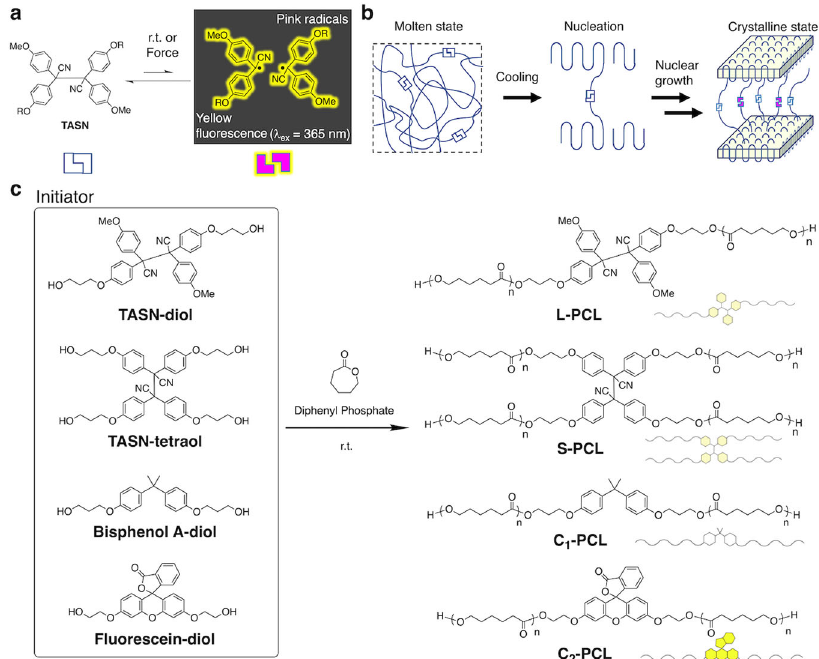
Fig. 1 Conceptual illustration of the TASN moiety as a fl uorescent probe and schematic image of CIMF. a Chemical structure of tetraarylsuccinonitrile (TASN) and its equilibrium with the corresponding C – C-cleaved radicals. b Schematic image of the crystallization of a TASN-centered polymer from its molten state. c Synthetic scheme of TASN-containing linear polycaprolactone ( L-PCL ), TASN-containing star polycaprolactone ( S-PCL ), and control polycaprolactones that contain bisphenol A ( C 1 -PCL ) or fl uorescein ( C 2 -PCL ) at the center of the